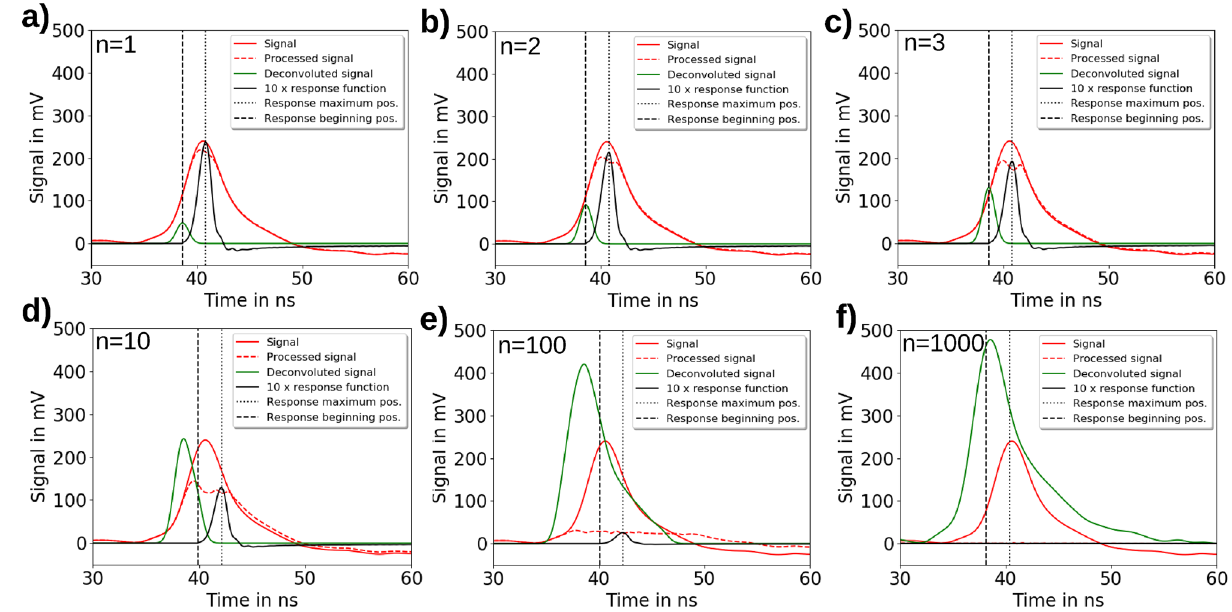
Figure 6. The iterative algorithm used for deconvolution of the measured time-of-flight (ToF) signal with the ToF beam monitoring system (BMS) time response function. Here, the red solid line is the measured ToF signal and the red dashed line is the processed ToF signal resulting from the iterative subtraction of the ToF BMS time response function shown as the black solid line. The green solid line shows the resulting deconvoluted ToF BMS signal. At the beginning, the processed ToF signal is identical with the measured ToF signal. During the iterative deconvolution process the ToF BMS response function maximum (dotted black line) gets aligned for best overlap with the processed ToF signal and the response function maximum is normalized to 10% of the processed ToF signal hight at this position. Then the ToF BMS response is subtracted from the processed ToF signal and then added to the deconvoluted signal as a symmetrical Gaussian function with the same area and FWHM, centered at the ToF BMS response function beginning (dashed black line). This process is repeated until the processed ToF signal reaches a stable minimum. The iteration steps 1, 2, 3, 10, 100 and 1000 are shown in ( a )–( f ),